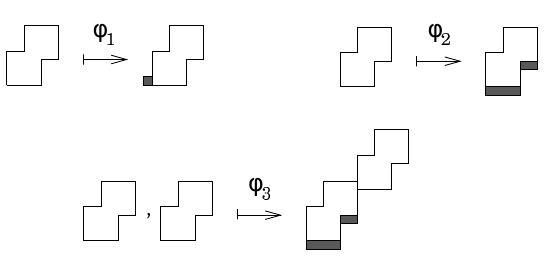
Fig. 2: A parallelogram polyomino.